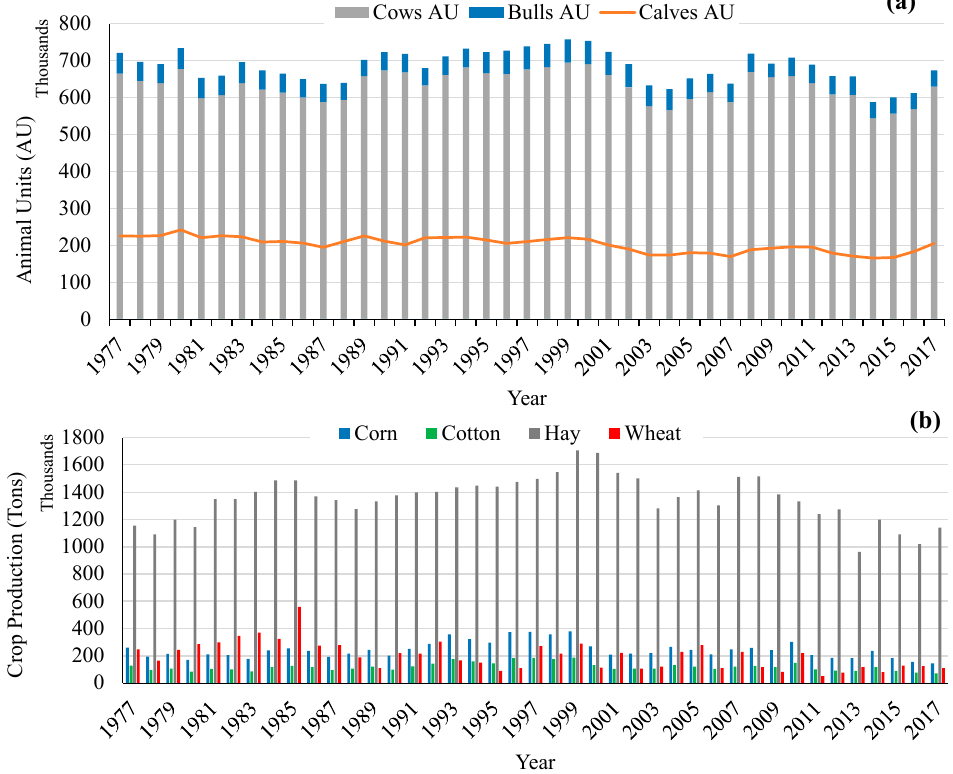
Figure 2. New Mexico beef cows, bulls, and weaned calves as animal units (AU) ( a ) and main crops ( b ) between 1977 and 2017 [19].